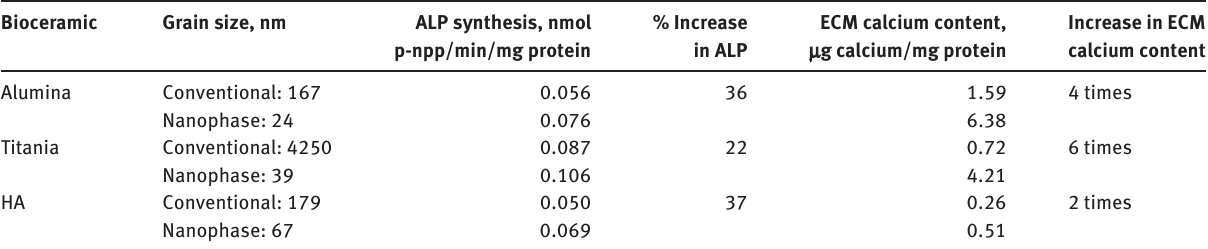
Table 2 Percent increase in ALP and ECM calcium content for osteoblasts cultured on nanoscale compared with microscale bioceramics after 28 days